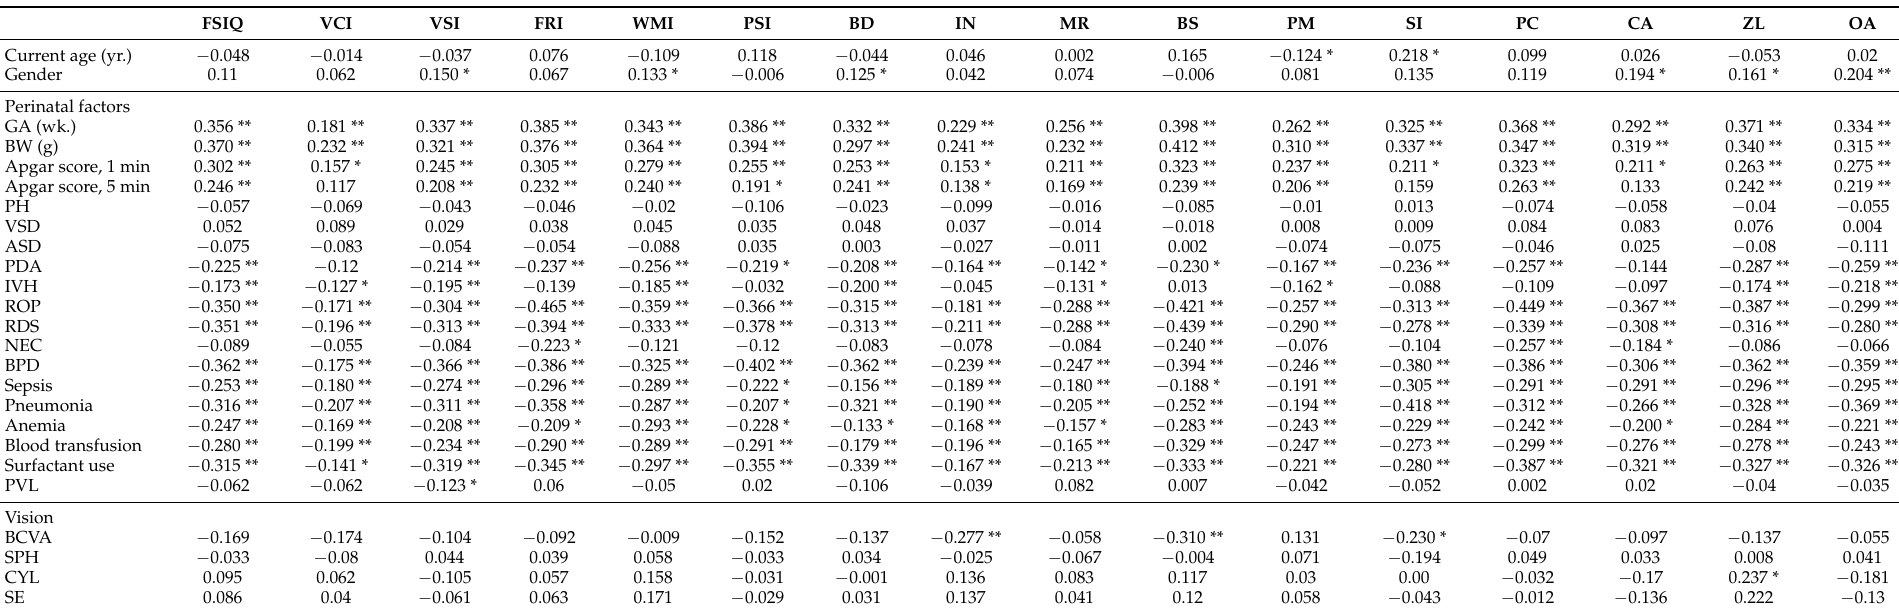
Table 5. The correlations between WPPSI-IV variables demographic data, clinical data, and